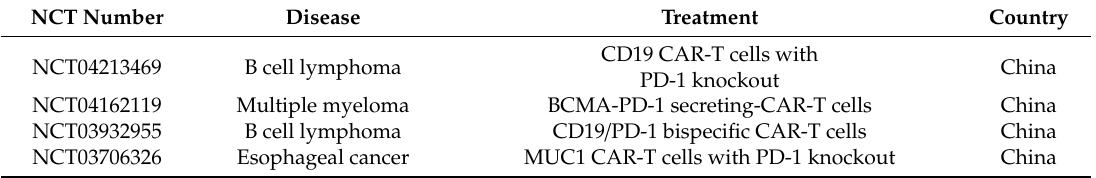
Table 3. Overview of clinical trials with genetically engineered CAR-T cells